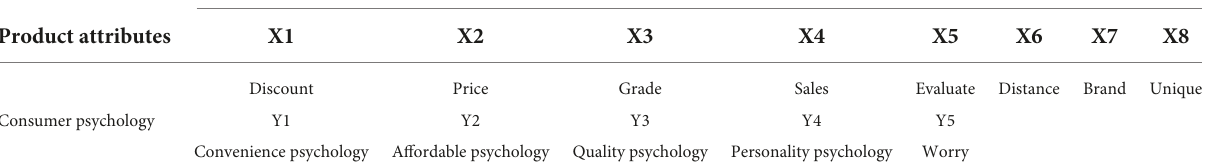
TABLE 4 Commodity attributes and consumer psychological content indicators.